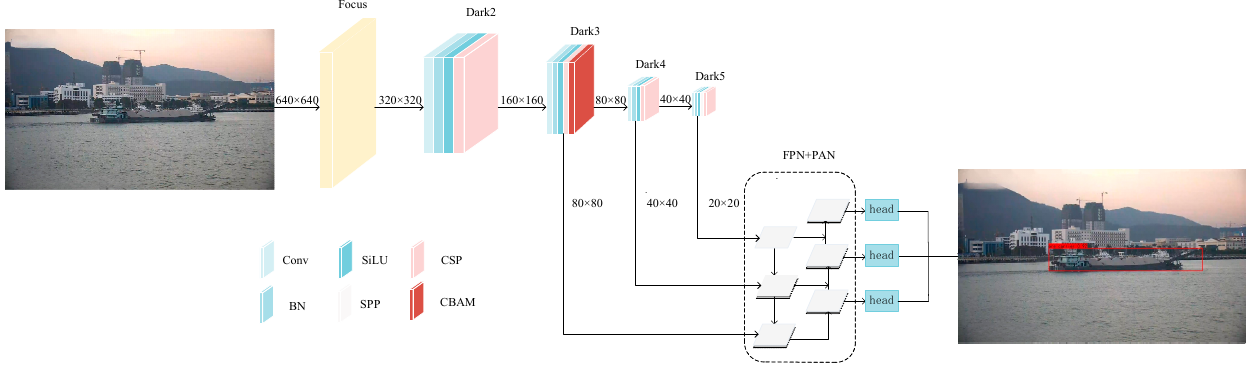
Figure 1. CBAM-YOLOX network structure.